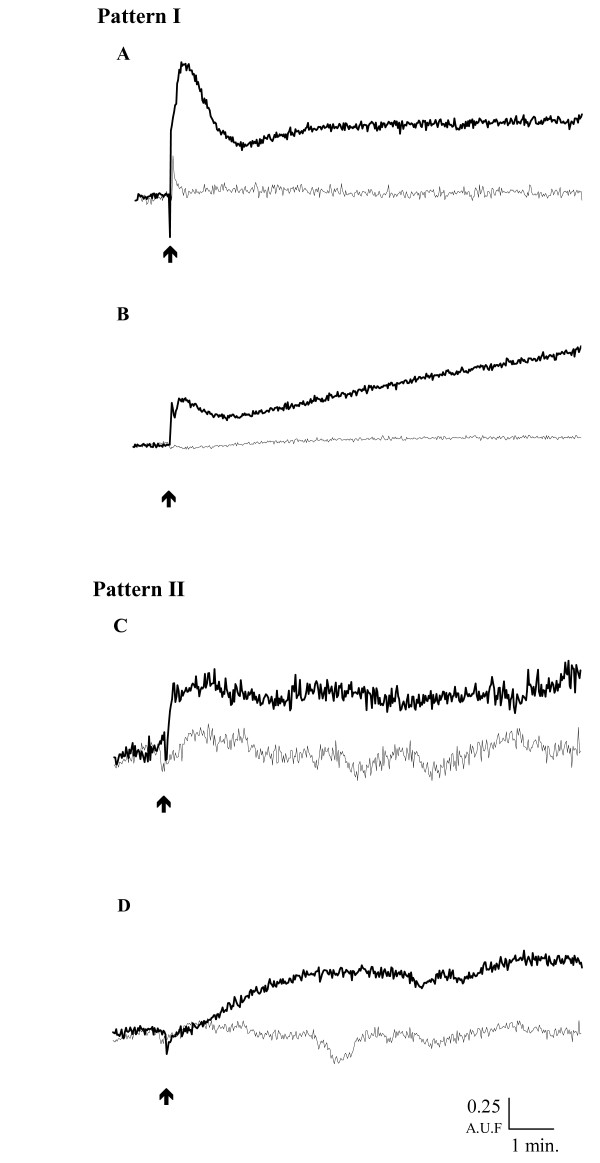
Time-course of the intracellular Ca2+ modifications induced by human zona pellucida in spermatozoa. Capacitated, Fura-2-loaded spermatozoa (15 × 106/ml) were incubated at 37°C in BWW medium. After stabilisation of the fluorescent signal, solubilised hZP (2/μl final concentration) (heavy line) or the same volume of solvent (light line) was added to the sperm suspension (arrow). Results are expressed as the fluorescence excitation ratio (340/380 excitation wavelengths, in arbitrary fluorescence units (AFU)) as a function of time (min). Two patterns of change in calcium concentration were observed in response to the addition of hZP to sperm samples: biphasic (Pattern I A and B) or monophasic (Pattern II C and D).